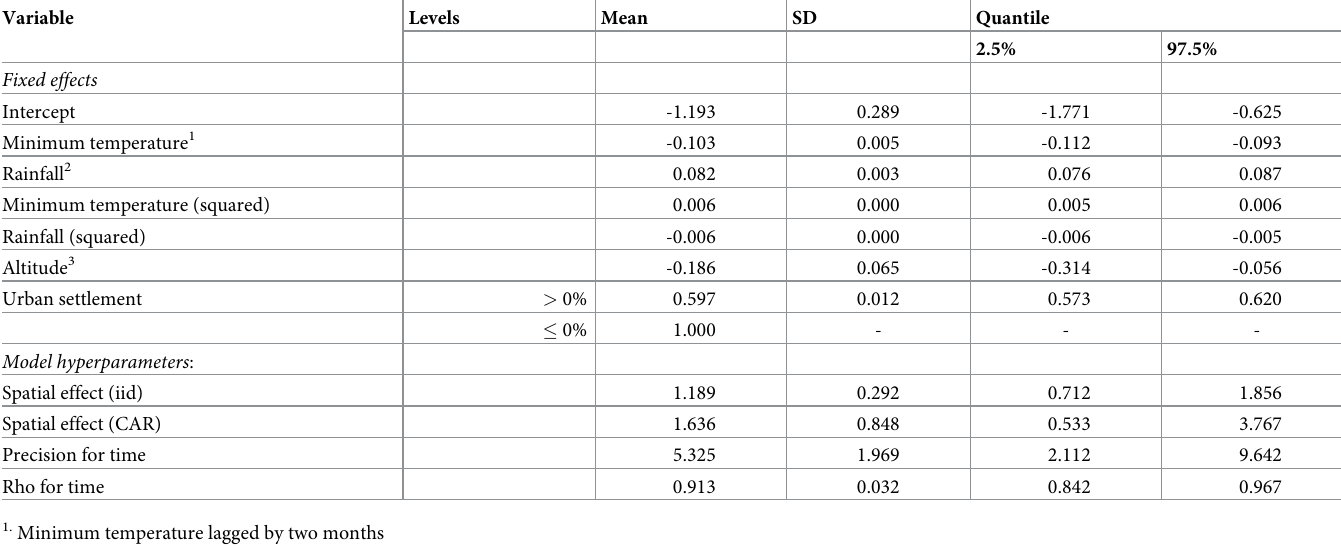
Table 2. Marginal posterior distributions of model parameters estimated from a parsimonious hierarchical Bayesian spatial model fitted to dengue fever data from Vietnam (2001–2010).